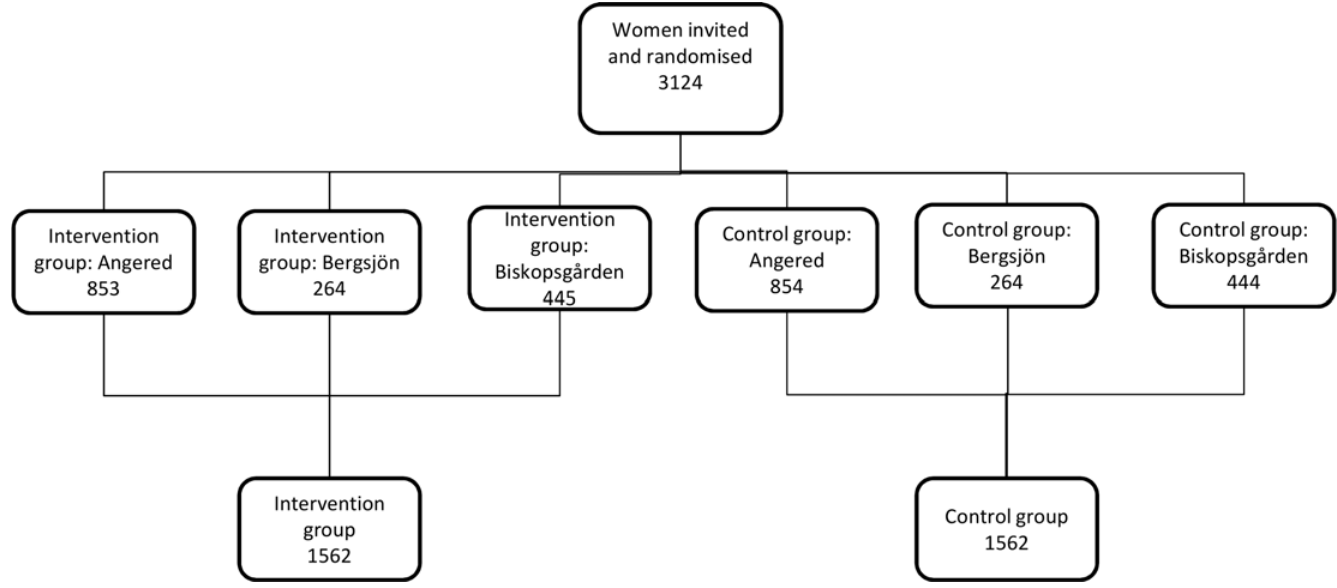
Fig 1. Flow chart of the study. There were no exclusions and no protocol